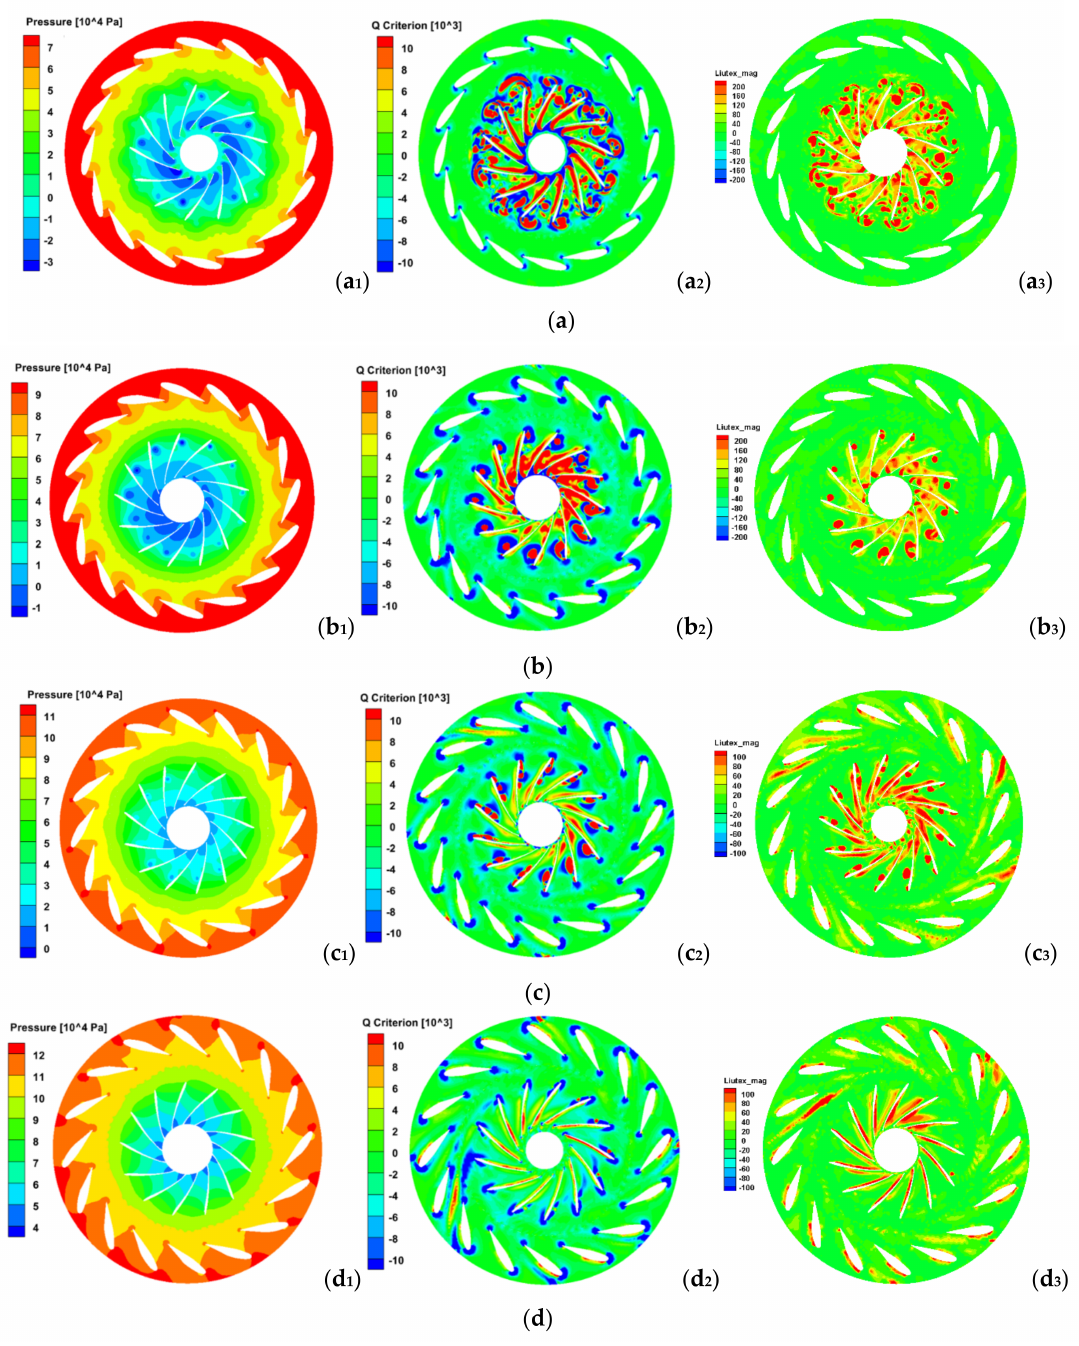
Figure 9. Meridian section of guide vane and runner domain. ( a ) α = 13.50 mm (small opening condition): ( a 1 ) Pressure (Pa), ( a 2 ) Q criterion, ( a 3 ) Liutex; ( b ) α = 26.17 mm: ( b 1 ) Pressure (Pa), ( b 2 ) Q criterion, ( b 3 ) Liutex; ( c ) α = 38.05 mm: ( c 1 ) Pressure (Pa), ( c 2 ) Q criterion, ( c 3 ) Liutex; ( d ) α = 48.74 mm (optimal condition): ( d 1 ) Pressure (Pa), ( d 2 ) Q criterion, ( d 3 )